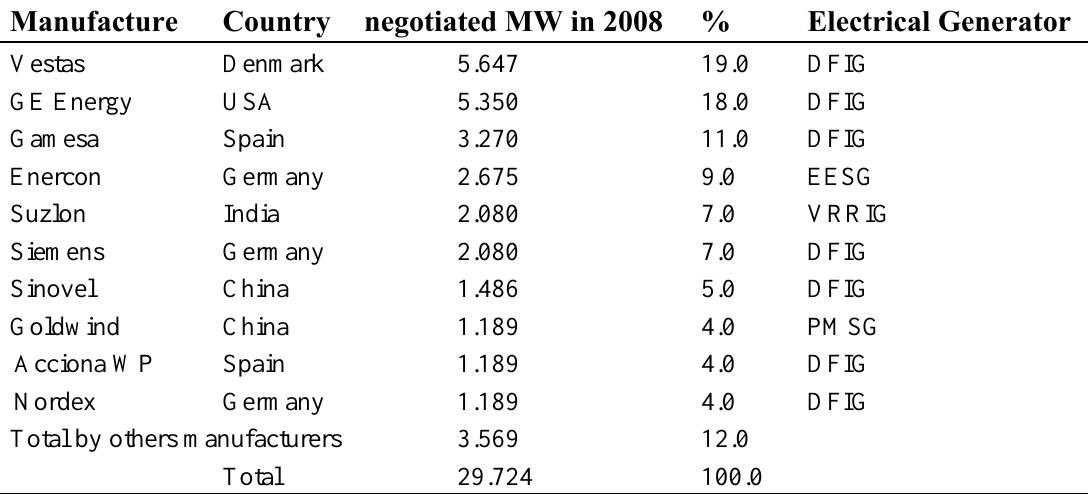
Table 2. World market share in 2008 for the world largest manufacturers (published in [4]) (composed using the data from the manufacturers